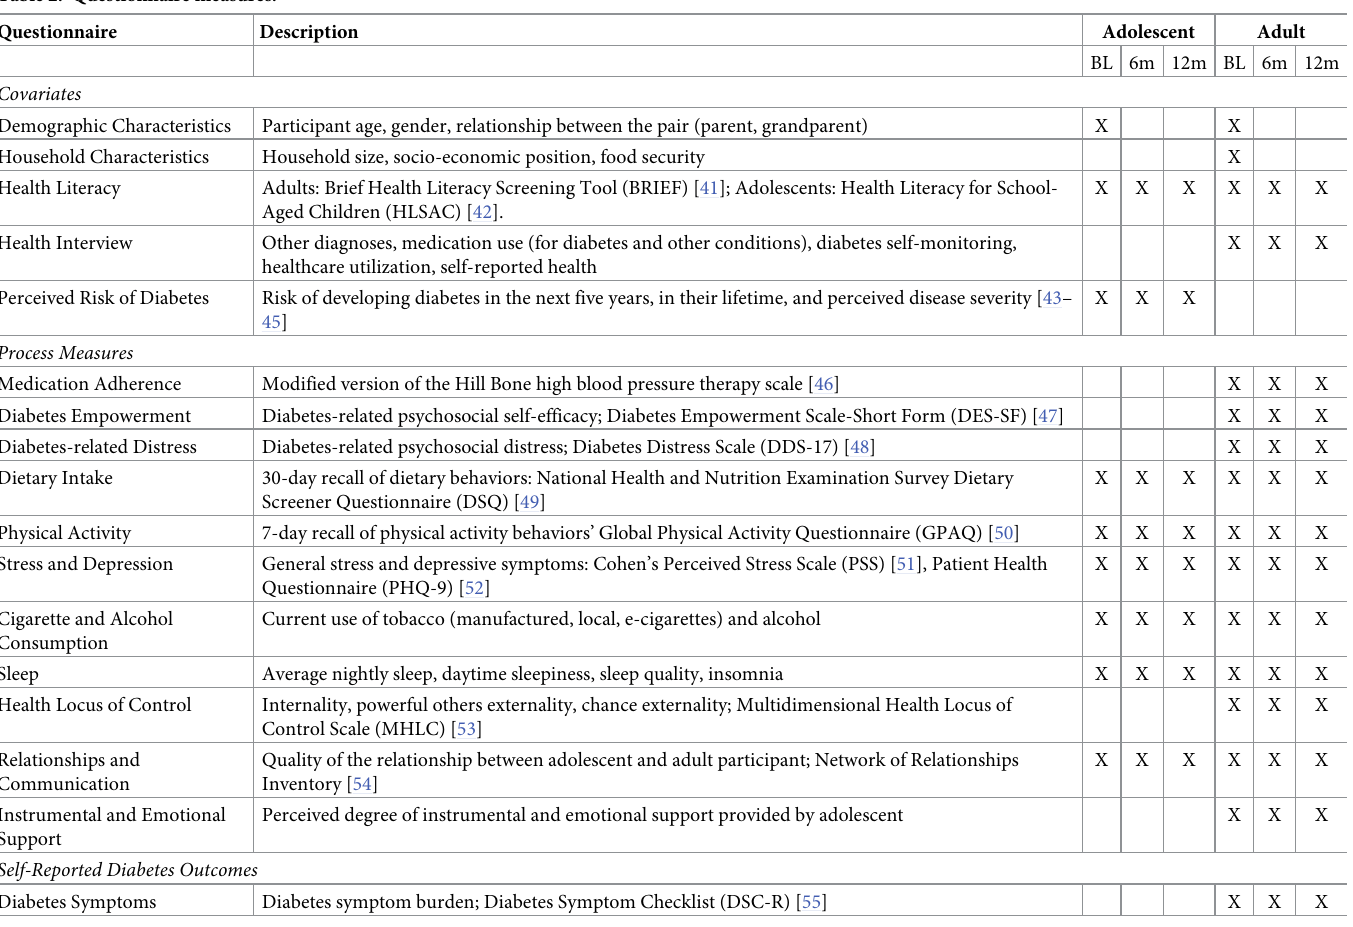
Table 2. Questionnaire